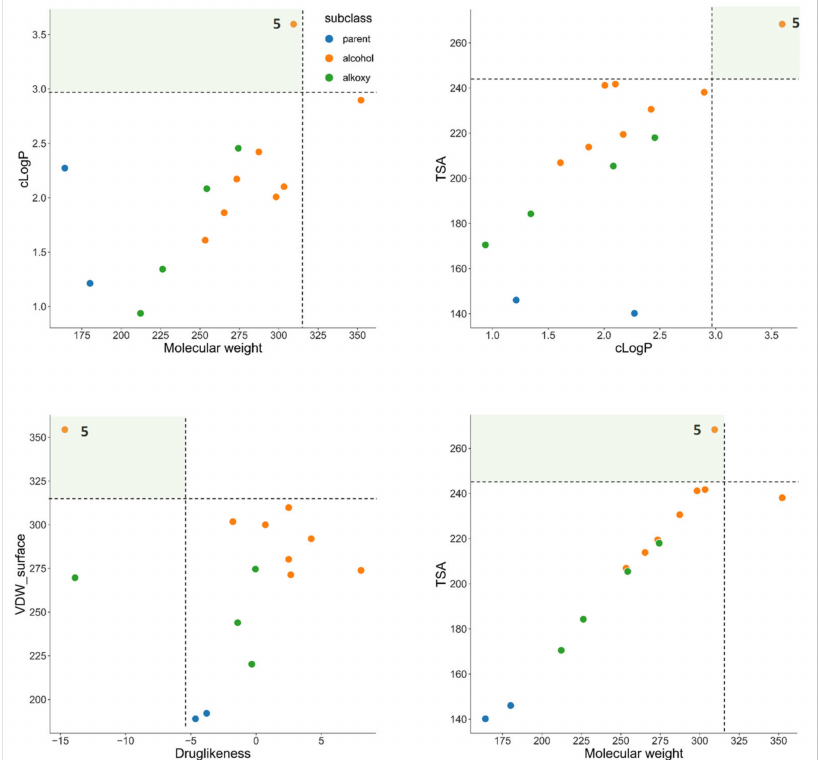
Figure 7. Chemical space occupied by the parent molecules 1 and 2 (blue dots) and β -amino ( 3 – 9 , 14 —orange dots)/ β -alkoxy ( 10 – 13 —green dots) alcohol derivatives. cLogP, calculated partition coefficient; TSA, total surface area; VDW, van der Waals